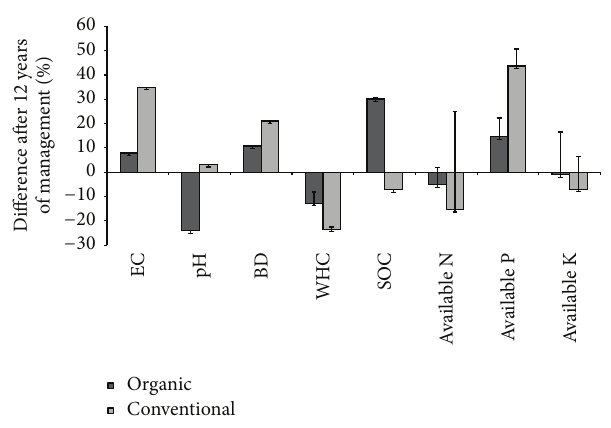
Figure 1: Impact of 12 years of organic and conventional manage- ment in coffee on selected soil physical and chemical